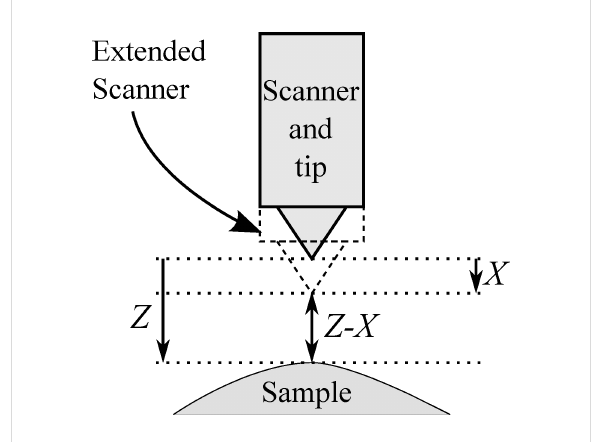
Figure 1: Schematic showing coordinates for sample position, Z , and scanner extension, X . The tip–sample distance can then be calculated as Z – X